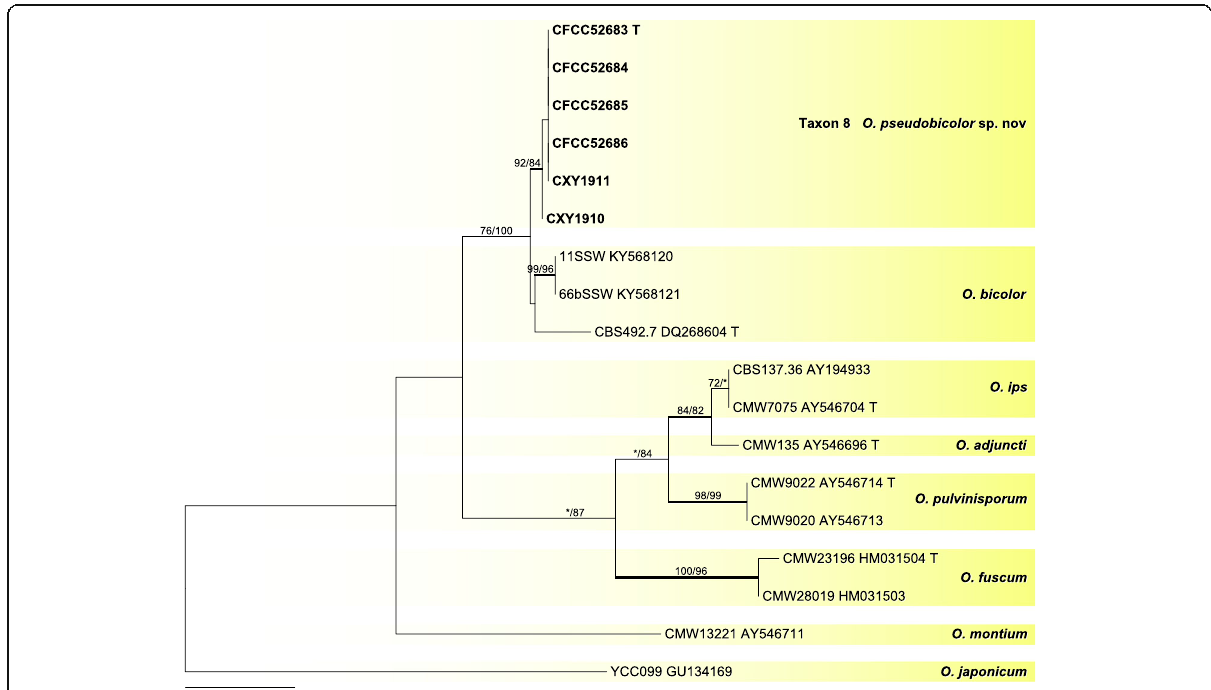
Fig. 7 ML tree of O. ips complex generated from the ITS sequence data. Sequences generated from this study are printed in bold. Bold branches indicate posterior probability values ≥ 0.9. Bootstrap values of ML/MP ≥ 70% are recorded at the nodes. T = ex-type